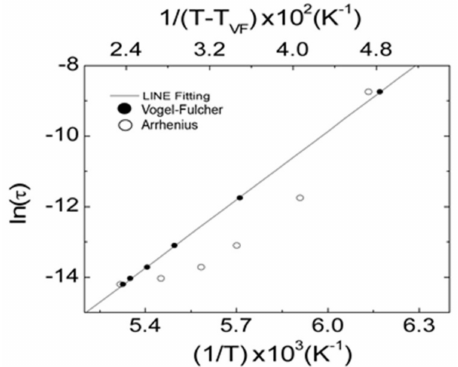
Figure 6. The variation of relaxation time ( τ ) with temperature for Arrhenius ( ◦ ) and Vogel–Fulcher ( ) type relaxation freezing for the reentrant relaxor ferroelectric (FE)